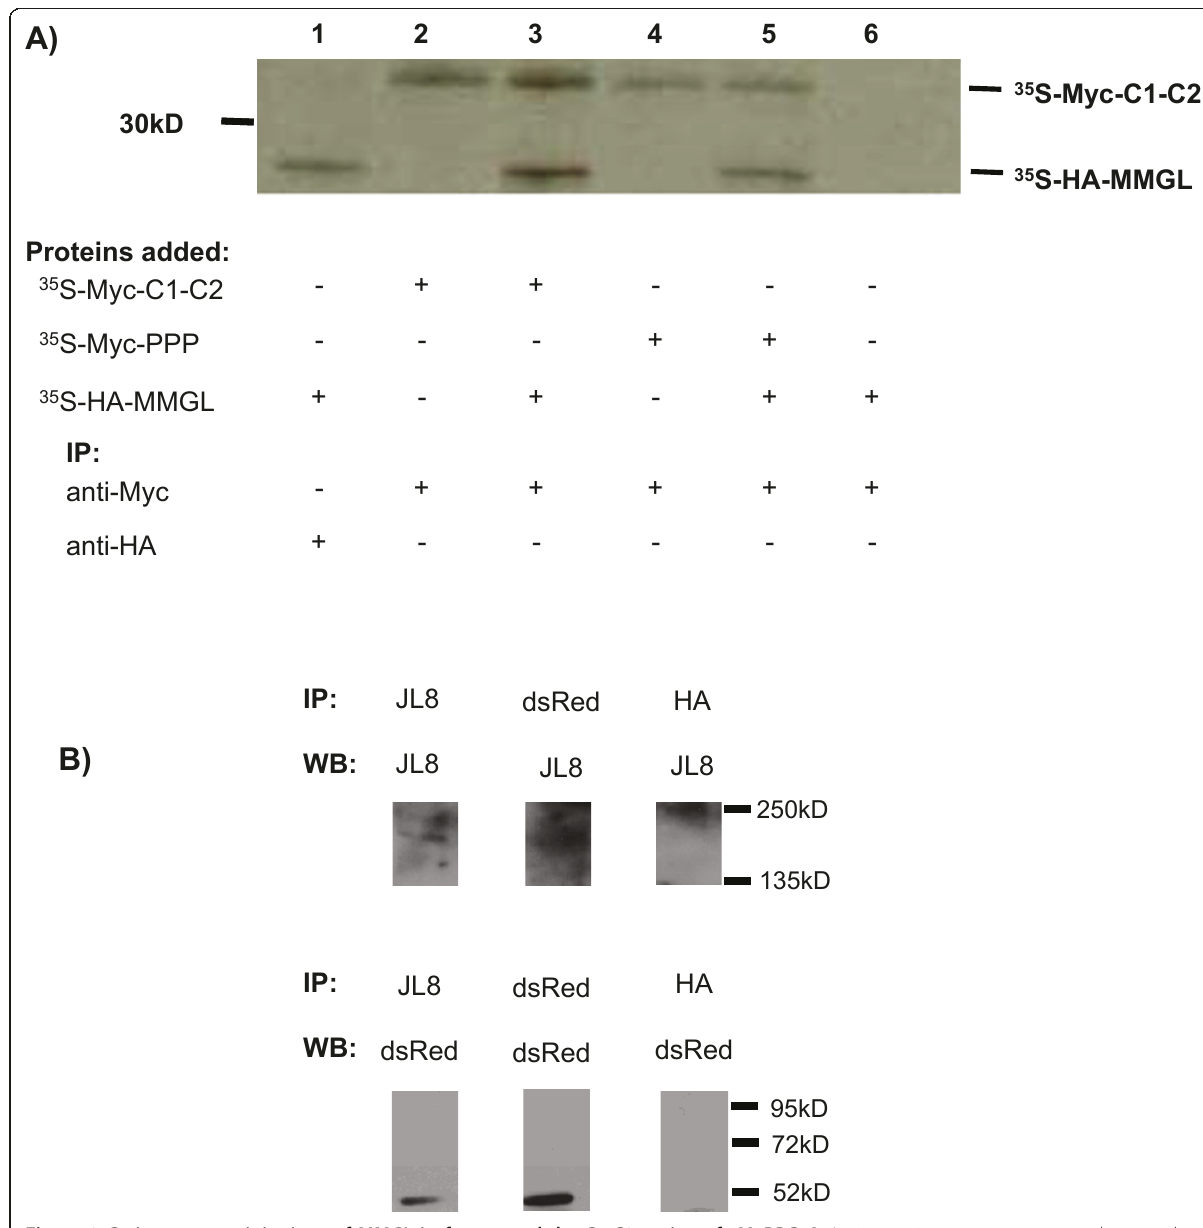
Figure 2 Co-immunoprecipitations of MMGL isoform 4 and the C1-C2 region of cMyBPC . A . In vitro co-immunoprecipitation showing that MMGL interacts with the native as well as the trisphospho-mimic of C1-C2 in the absence of Y2H GAL4 domains. B . In vivo co- immunoprecipitation, showing that dsRed-tagged MMGL is able to specifically pull down GFP-cMyBPC, and vice versa , in H9C2 cells. Abbreviations: JL8 = antibody directed against GFP, dsRed = antibody directed against dsRed-tagged proteins, HA = antibody directed against haemaglutinin protein, used as negative control antibody, IP = antibody used in immunoprecipitation, WB = antibody used in western